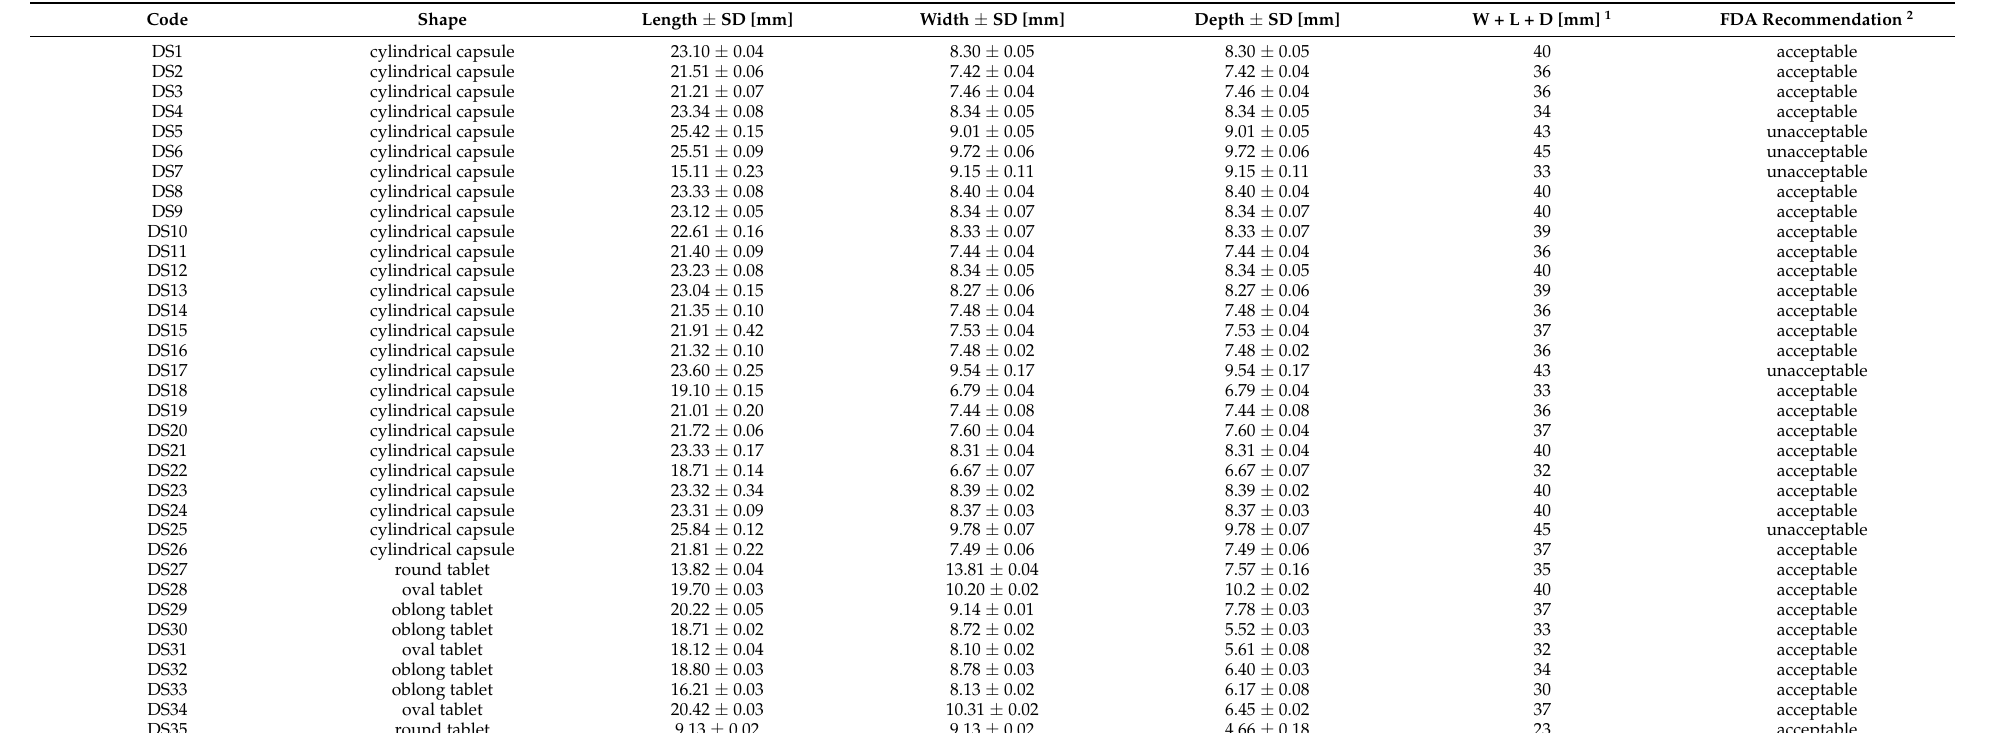
Table 1. Analysis of shape and size of the analysed dietary